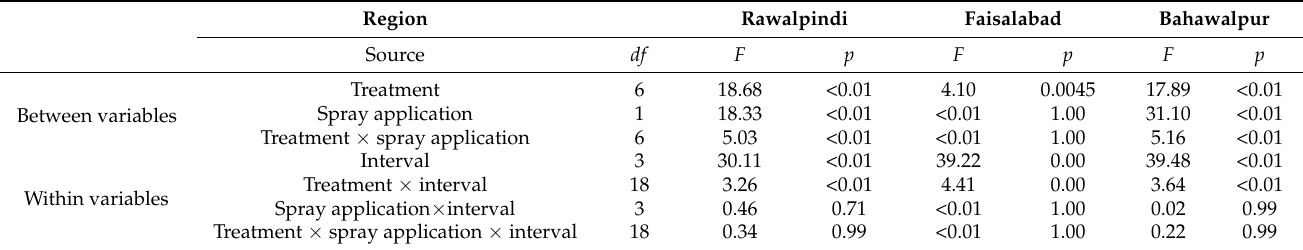
Table 1. Repeated measures MANOVA for main effects and associated interactions for larval popula- tion of H. armigera (total df = 167). Region Rawalpindi Faisalabad